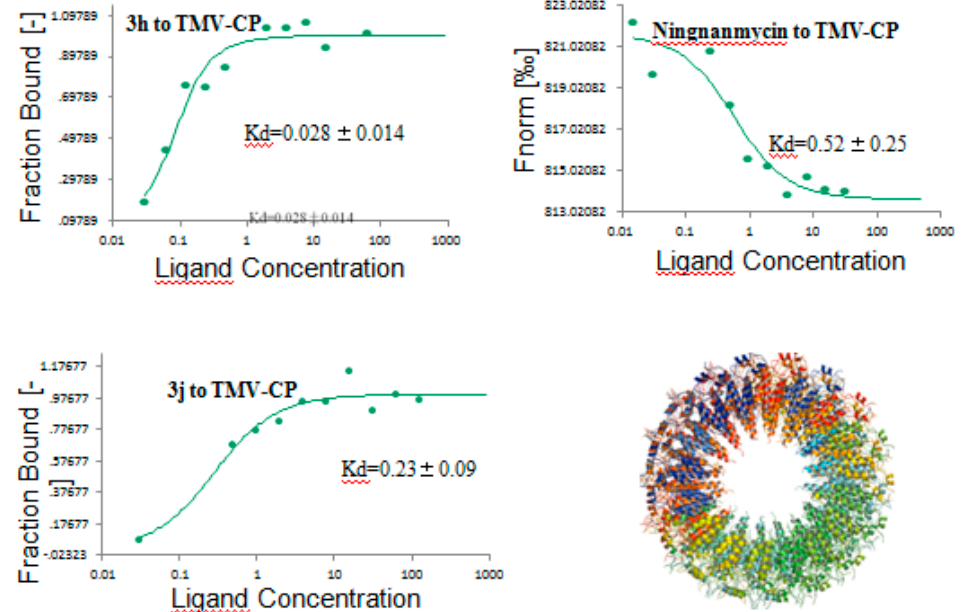
Figure 3. Microscale thermophoresis (MST) results of compounds 3h and 3j , and ningnamycin .